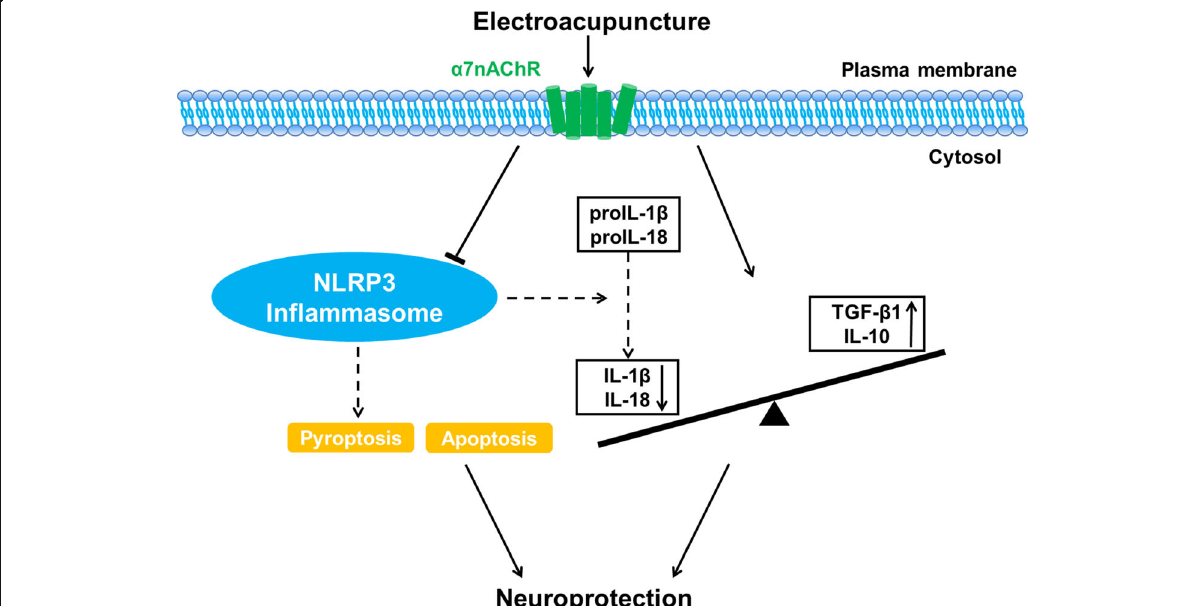
Fig. 9 Schematic diagram illustrating the mechanisms of EA-induced neuroprotection. Electroacupuncture attenuated cerebral ischemic injury and neuroinflammation through α 7nAChR-mediated inhibition of NLRP3 inflammasome in stroke